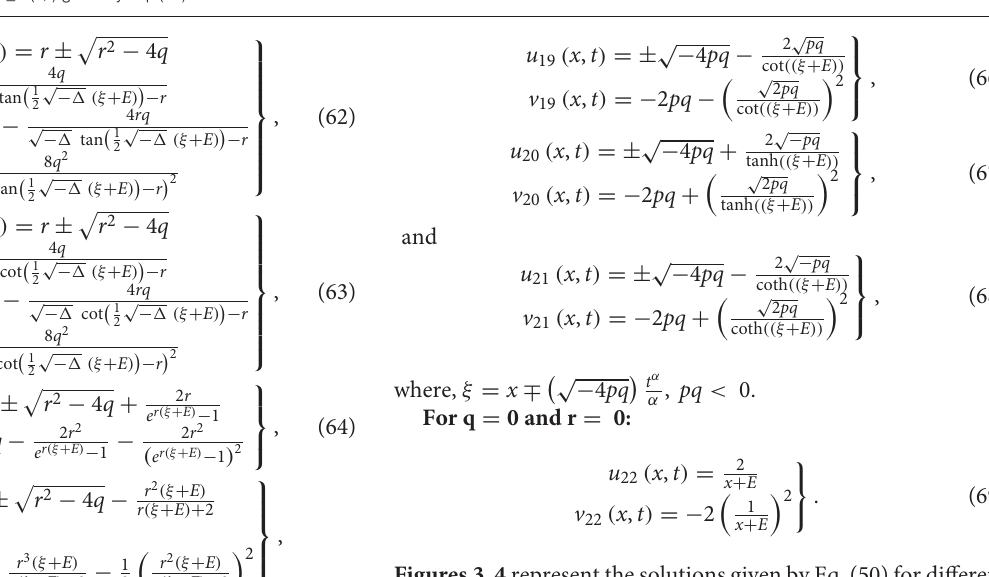
FIGURE 2 | (A–D) The Solution v_1 (x,t) given by Eq.